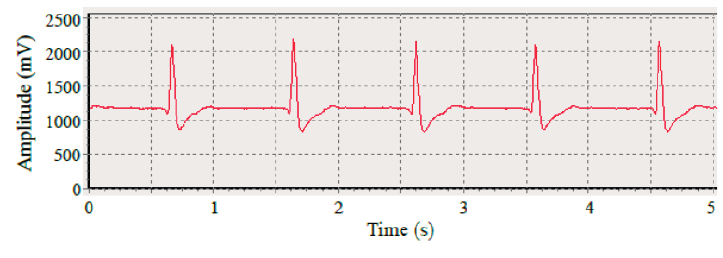
Figure 15. ECG signals obtained using ( a ) the standard wet electrodes; and ( b ) barbed dry